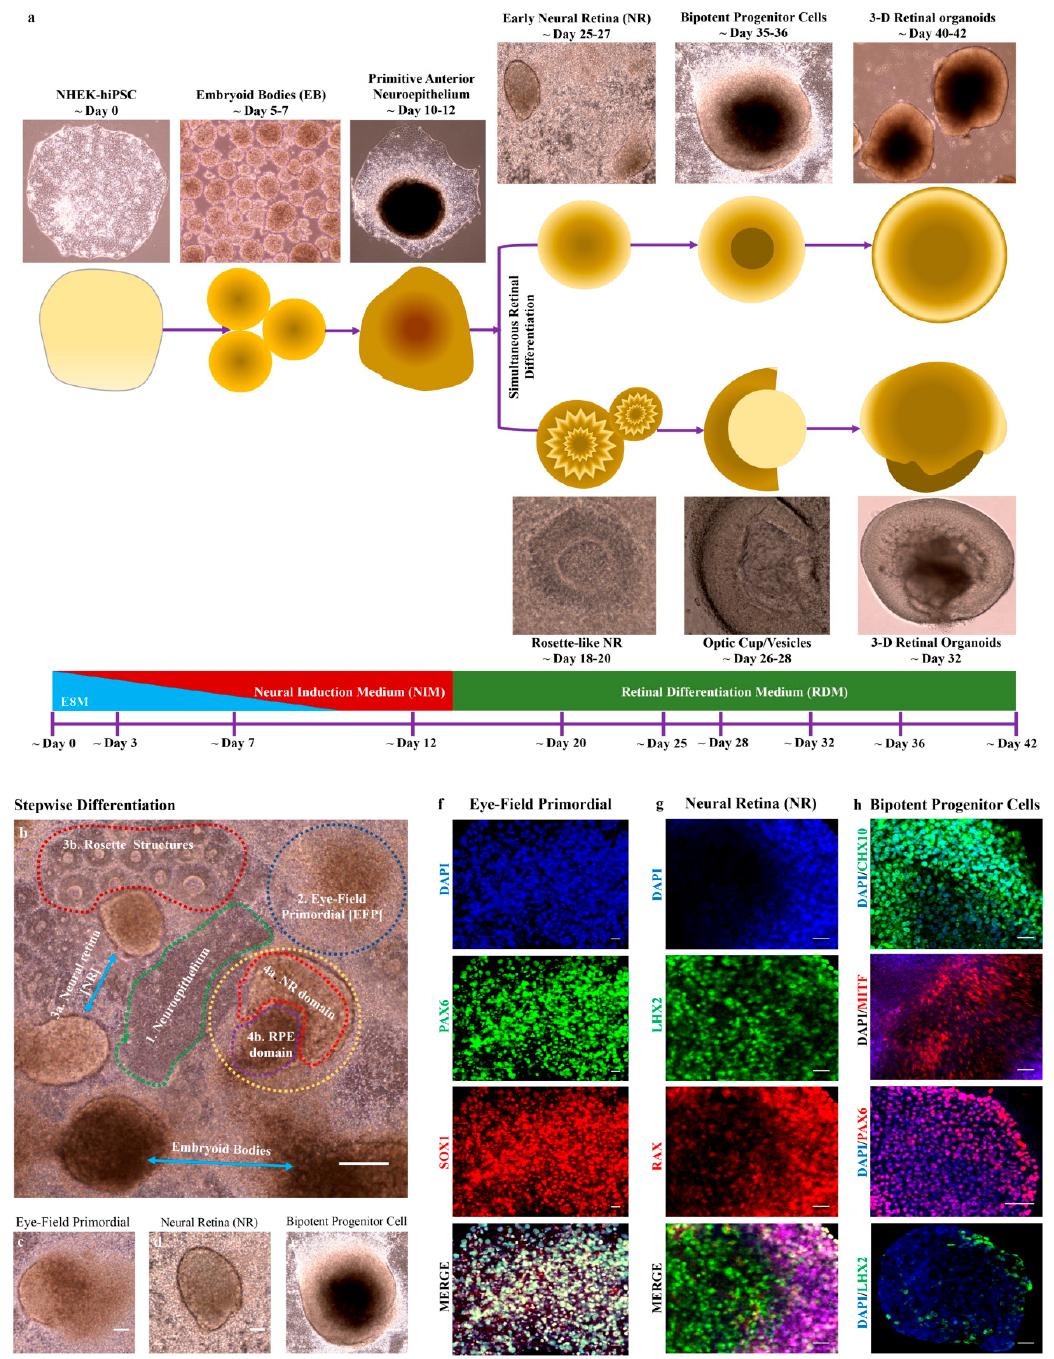
Figure 4. hiPSC-derived 3-D embryoid bodies differentiated into retinal progenitors that were self-organized into eye-field primordial cells and formed neural retina (NR) cells and bipotent retinal progenitor cells. ( a ) Schematic illustration showing the generation of retinal organoids either via bipotent retinal progenitor cells or the optic cup/vesicles system; ( b ) Differentiation of EBs in a stepwise manner of early eye development; ( c – e ) 2-D cell culture with representative image of eye field primordial cells, neural retina (NR) cells and bipotent retinal progenitor cells; and ( f – h ) immunocytochemistry staining the expressing eye field primordial cells ( PAX6 and SOX1 ) ( f ); neural retina cells ( LHX2 and RAX ) ( g ); & bipotent progenitor cells ( CHX10 , MITF , PAX6 and LHX2 ) ( h ). Scale bars, 50 µ m ( c – e ); 100 µ m ( f , g , h ); 200 µ m ( b